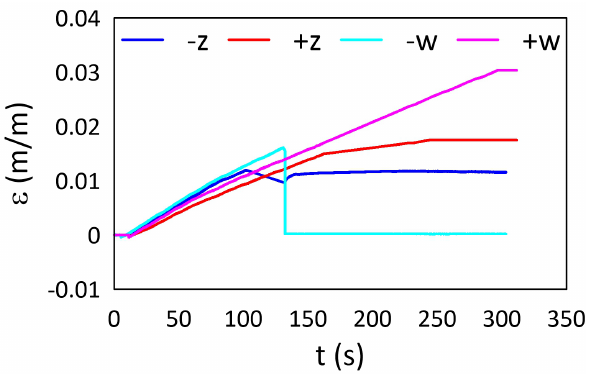
Figure 22. Strain determined for RW samples manufactured from M3 Crystal during the tensile test: w —embedded, z —attached, ‘+’—after exposing on the elevated temperatures, and ‘ − ’—after exposing on the sub-zero temperatures.